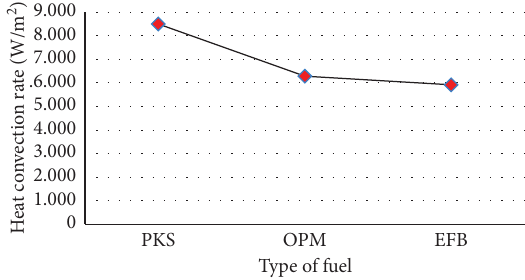
Figure 11: Heat convection rate for different fuels at the mea- surements